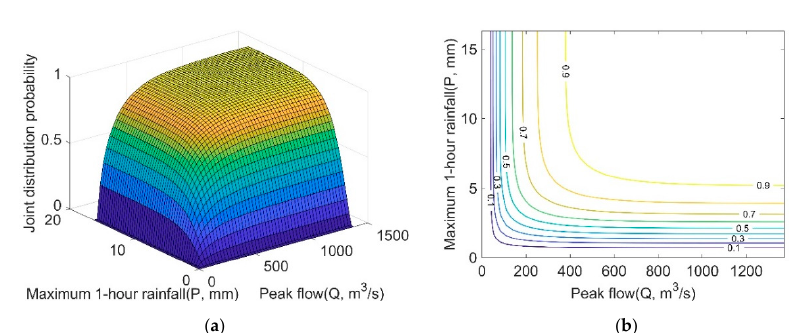
Figure 7. Probability distribution of P–Q using Frank ( a ) bivariate joint probability distributions; ( b ) probability isolines.